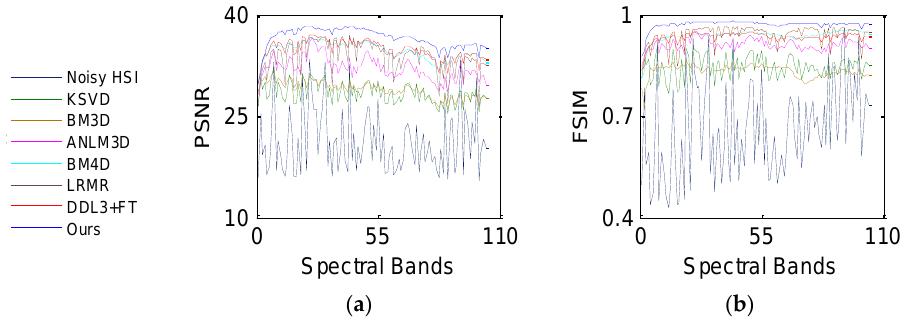
Figure 4. Quantitative evaluation results for Pavia data: ( a ) PSNR; ( b ) FSIM.